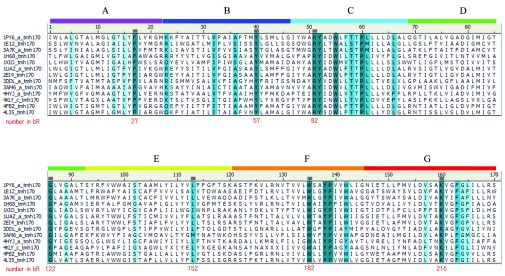
Sequence alignment of the 7TM regions of 13 MRs in set 3.The conserved positions are colored as follows: dark blue, identical; blue, strong similarity; light blue, weak similarity, according to PAM250 matrix definition. The small squares on the ruler indicate the *.50 positions of the numbering proposed for MRs.